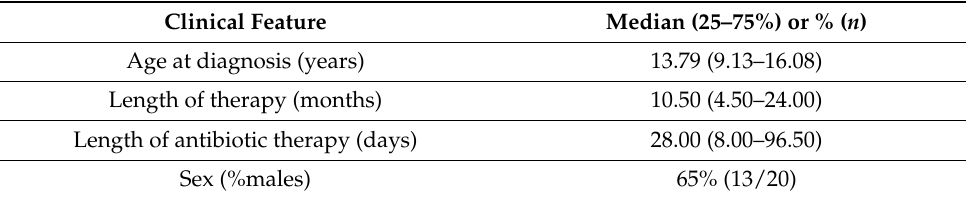
Table 1. Clinical characteristics of the study group ( n =